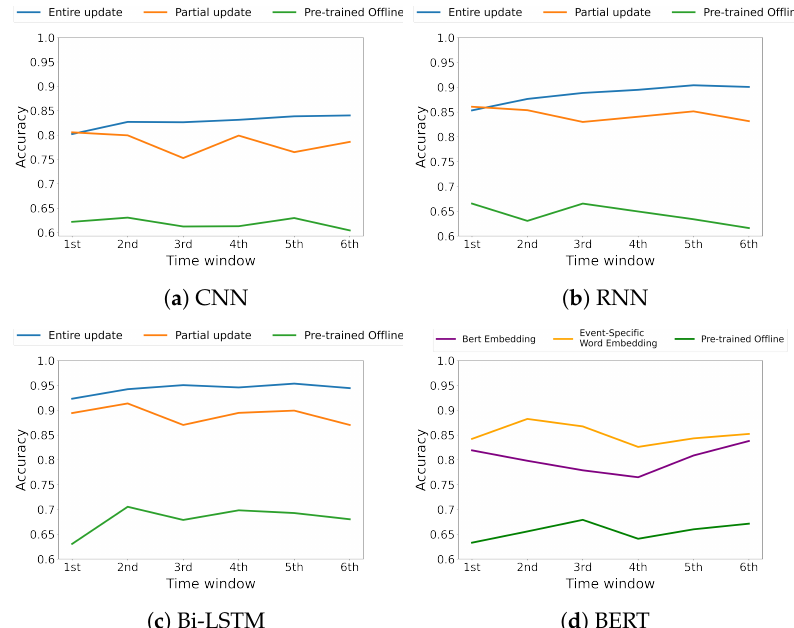
Figure 4. Accuracy comparison between (1) Pre-trained offline, (2) Entire model update, and (3) Partial model update on CSI dataset.